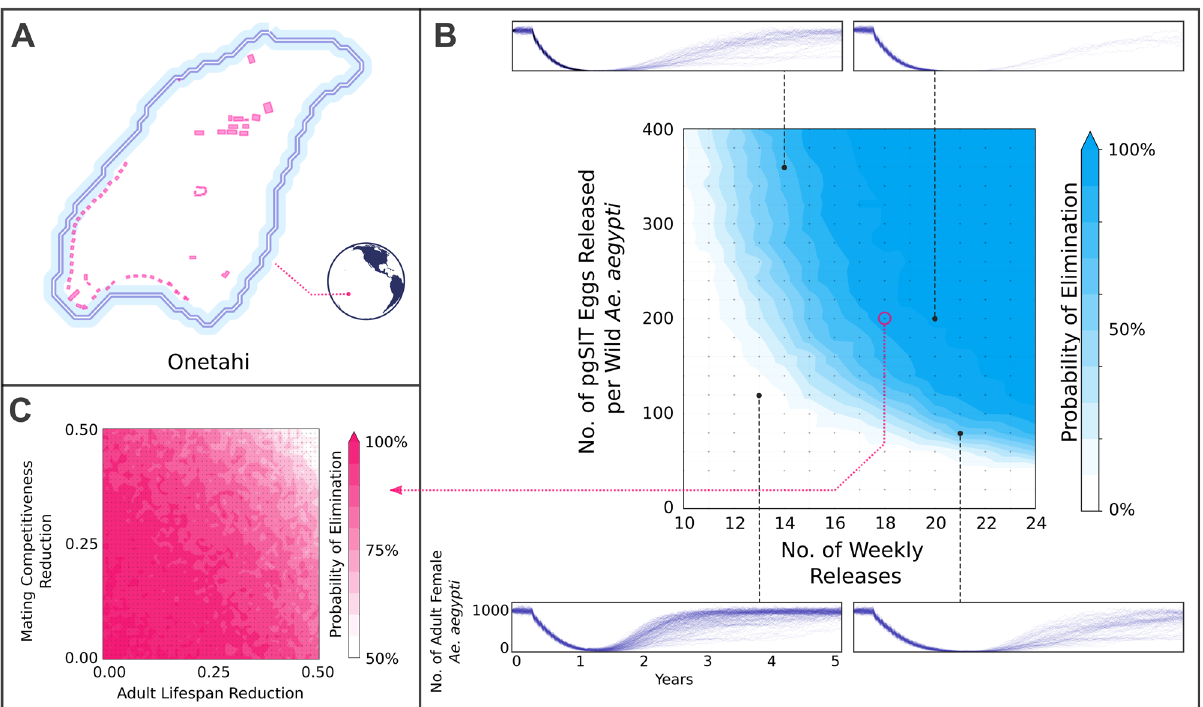
Fig. 4 Model-predicted impact of releases of pgSIT eggs on Ae. aegypti population density and elimination. A Releases were simulated on the motu of Onetahi (73.8 hectares), Teti ‘ aroa, French Polynesia, a fi eld site for releases of Wolbachia -infected ♂ mosquitoes, using the MGDrivE simulation framework 23 and parameters described in Supplementary Table 17. Human structures are depicted and were modeled as having an equilibrium population of 16 adult Ae. aegypti each. B Weekly releases of up to 200 pgSIT eggs per WT Ae. aegypti were simulated in each human structure over 10 – 24 weeks. The pgSIT construct was conservatively assumed to decrease ♂ mating competitiveness by 25% and adult lifespan by 25%. Elimination probability was calculated as the percentage of 200 stochastic simulations that resulted in local Ae. aegypti elimination for each parameter set. Sample time series depicting WT ♀ Ae. aegypti population density is depicted above and below the heatmap. C Elimination probability (given 18 weekly releases of 200